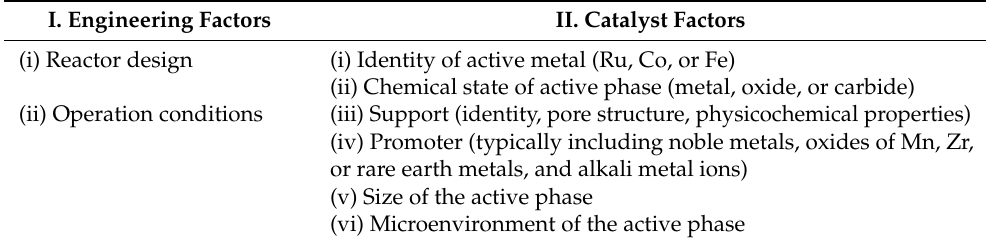
Table 3. Typical major parameters impacting FT catalyst activity and product selectivity